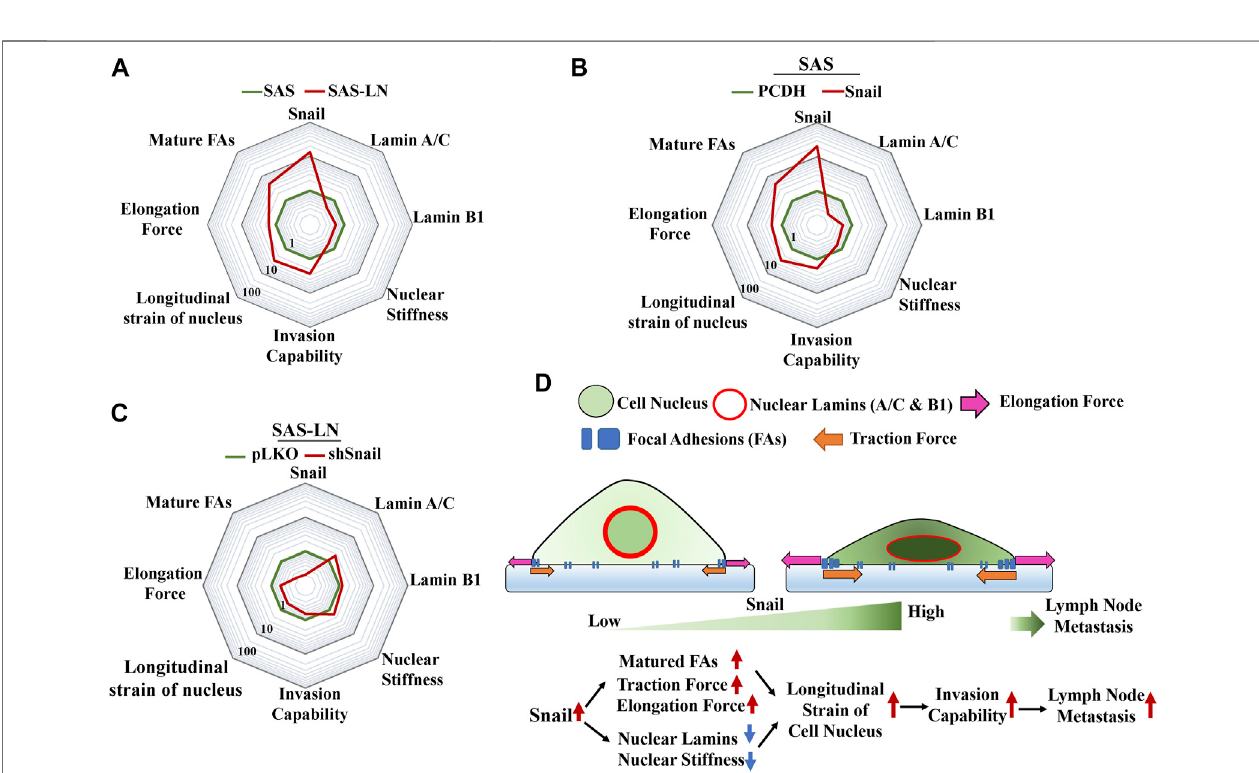
FIGURE 6 | cells in the microchannels. Data represent mean ± SD (n = 3). (I) Knockdown of Snail enhanced the expression of lamin A/C and B1. Left: western blot of lamin A/C and B1 in control (pLKO) and Snail1-knockdown SAS-LN cells (SAS-LN-shSnail). GAPDH was used as a loading control. Right: fold change expression of laminA/CandB1relativetothecontrol(pLKO)cells.Datarepresentmean±SD(n=3).*,for p < 0.05and**,for p < 0.01. (J) KnockdownofSnailreducedthenumberof mature FAs (FAs area > 1 μ m 2 ) and augmented the nascent FAs (FAs area < 1 μ m 2 ).Left: immuno fl uorescence micrographs ofthe cell nuclei, paxillin, and actin fi laments ofcontrol(SAS-LN-pLKO)andSnail-knockdownSAS-LNcells(SAS-LN-shSnail).Scalebars=20 μ m.Right:thenumbersoffocaladhesions(FAs)intheregions(8 μ m× 20 μ m) bounded by the white dotted rectangles in the lower panel in (J) . All data are expressed as mean ± SD from 15 cells.